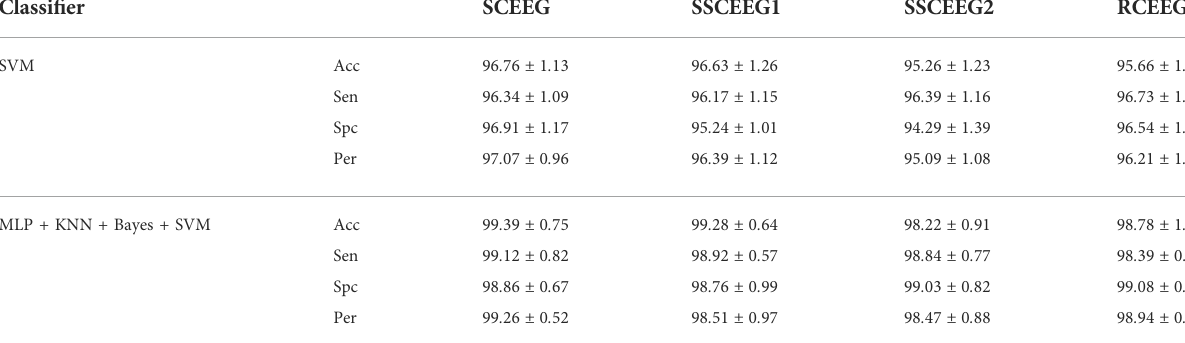
TABLE 9 Classi fi cation accuracy of all the classi fi ers and also the ensemble of them. Average values are mentioned here. Classi fi